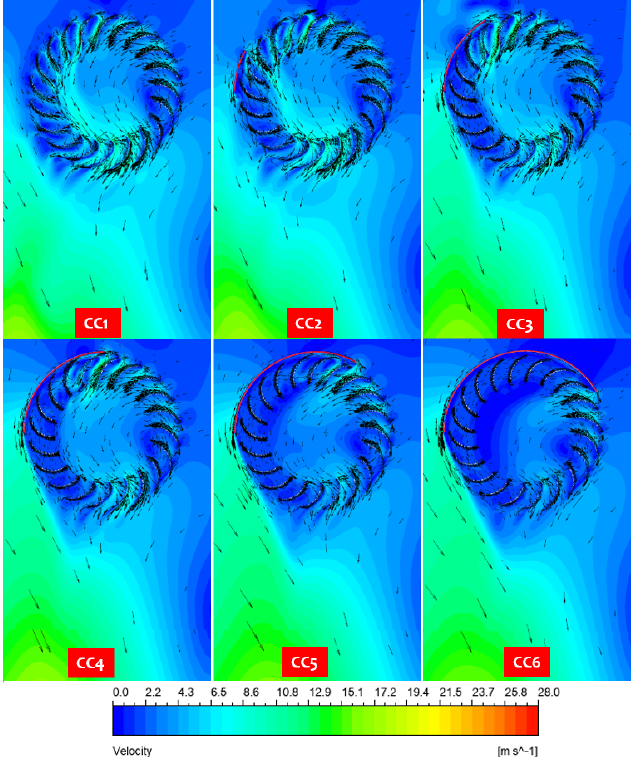
Figure 21. Velocity contours and vectors of each car case in the rotor zone taken at t = 3.8 s. From the minima, the curve starts to rise again and produce a smaller peak which is due to the apparent dissipation of vortices in this period. To visually show this, the wind direction on the period t = 4 s to t = 4.3 s for Car Case 3 is shown in Figure 22. The slightly varying wind direction is observed until near t = 5 s and eventually flatten to an almost horizontal direction beyond this instant. This direction is where the windshield gives an advantage. The velocity contour and vector for each car case in Figure 23 show the effectiveness of the windshield in blocking the wind hitting against the rotation. Looking back at the curve in part 3, the Car Case 2 gives the worst performance among cases with windshield, in the entire duration of part 3 of the curve. The reason is the windshield arc length in Car Case 2 being the shortest among other cases is not effective enough on blocking the wind hitting against the VAWT rotation, therefore, the increase in power from no windshield case is relatively low. By taking the energy produced by one pass of the vehicle, which is represented by the area under the instantaneous power curve, gives the overall comparison of the effectiveness of windshield with varying arc length for car cases. The numerical integration is applied with negative values excluded, and the results of the computation are summarized in Table 3. It shows that having the windshield with a 60-degree arc length (Car Case 3) gives the highest increase in energy which is a 16.14% increase from no the windshield